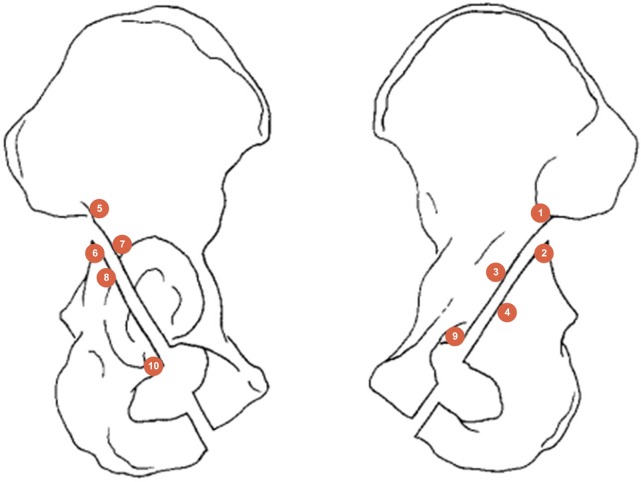
Positions of the strain gauges at 1–10 points around the acetabulum.